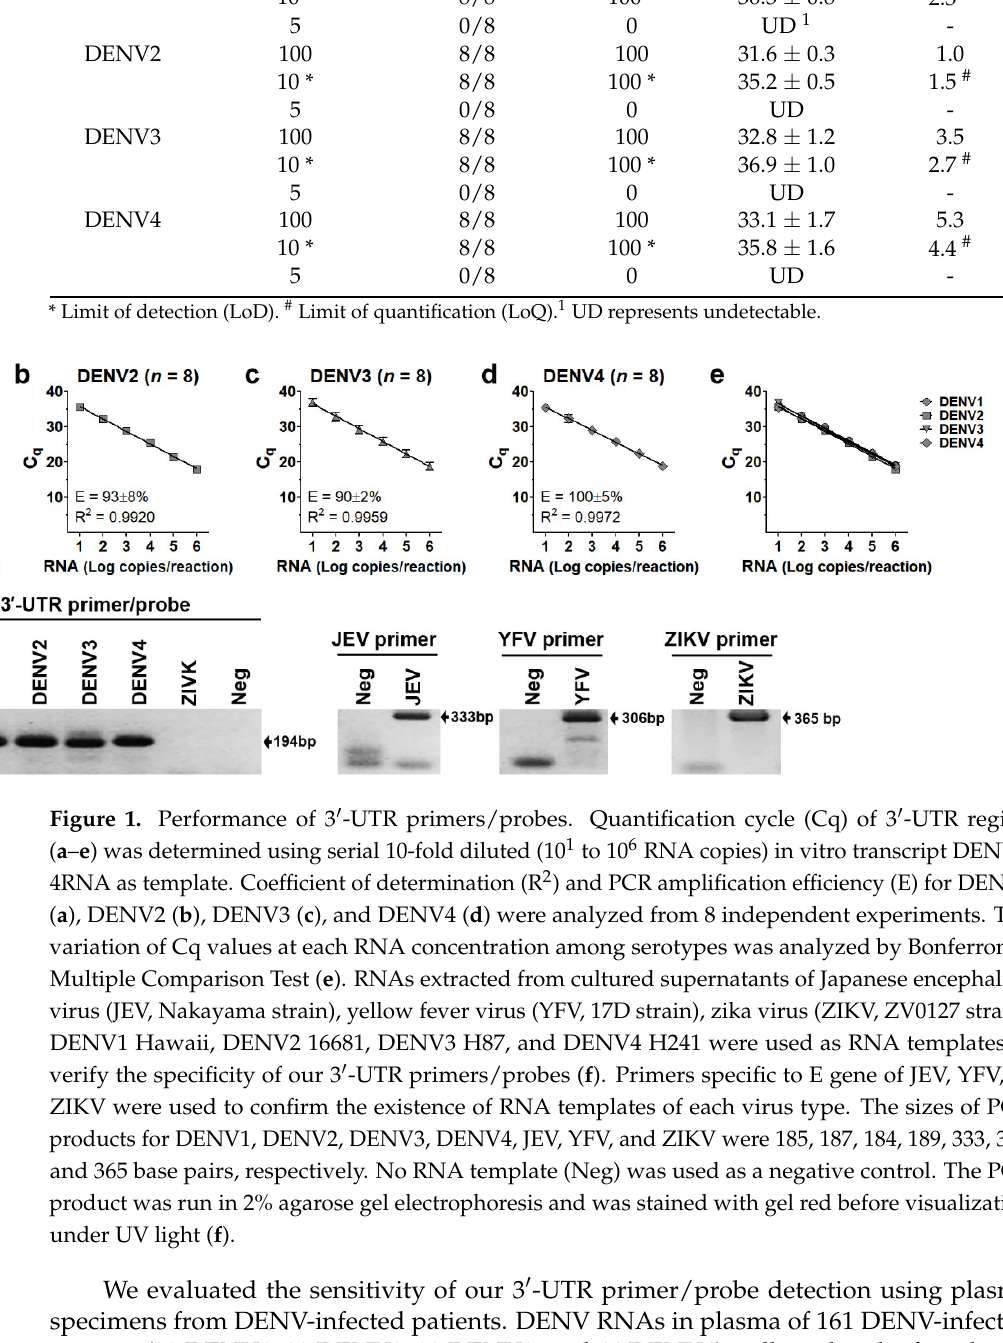
Table 4. Detection efficiency of the 3´-UTR RT-PCR assay on the first day of hospitalization. Total Patient Num- DENV Serotypes